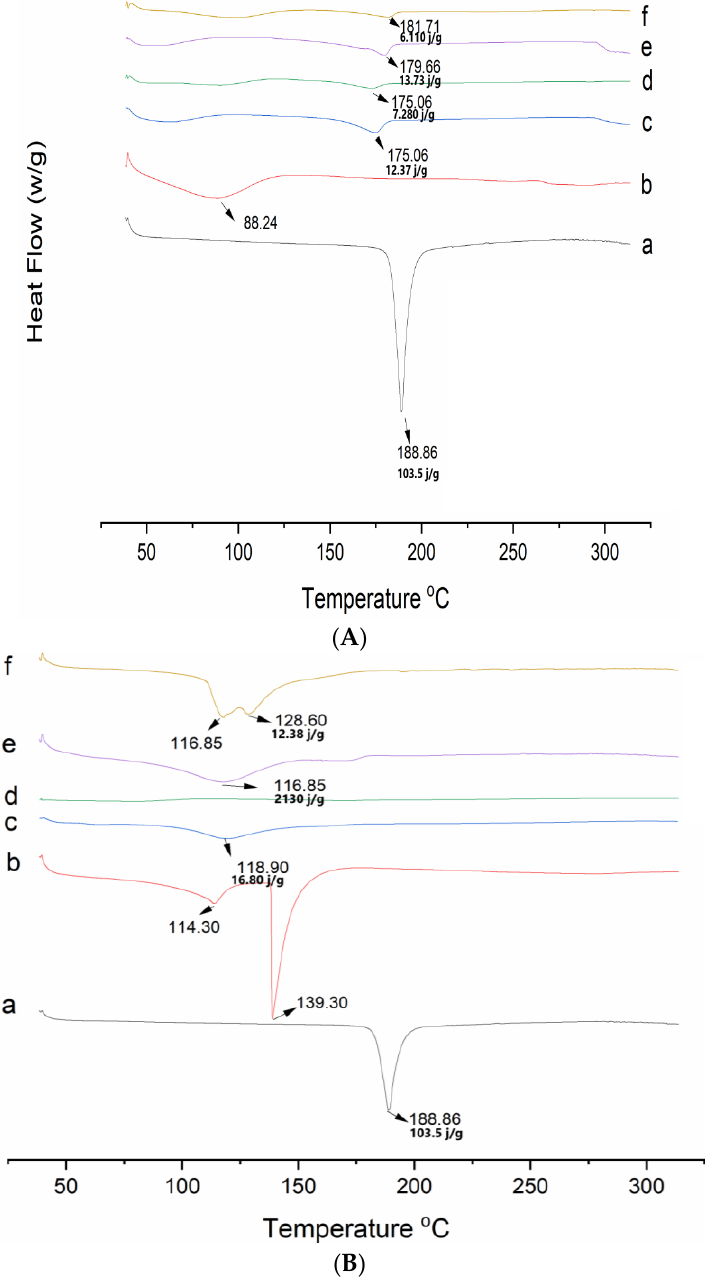
Figure 5. ( A ). DSC curves of (a) pure curcumin, (b) HPMC E5, (c) CUR:HPMC E5 1:2KN, (d) CUR:HPMC E5 1:4 KN, (e) CUR:HPMC E5 1:2 SE, and (f) CUR: HPMC E5 1:4 SE. ( B ). DSC curves of (a) pure curcumin, (b) PVP K30, (c) CUR:PVP K30 1:2 KN, (d) CUR:PVP K30 1:4 KN, (e) CUR:PVP K30 1:2 SE, and (f) CUR:PVP K30 1:4 SE.